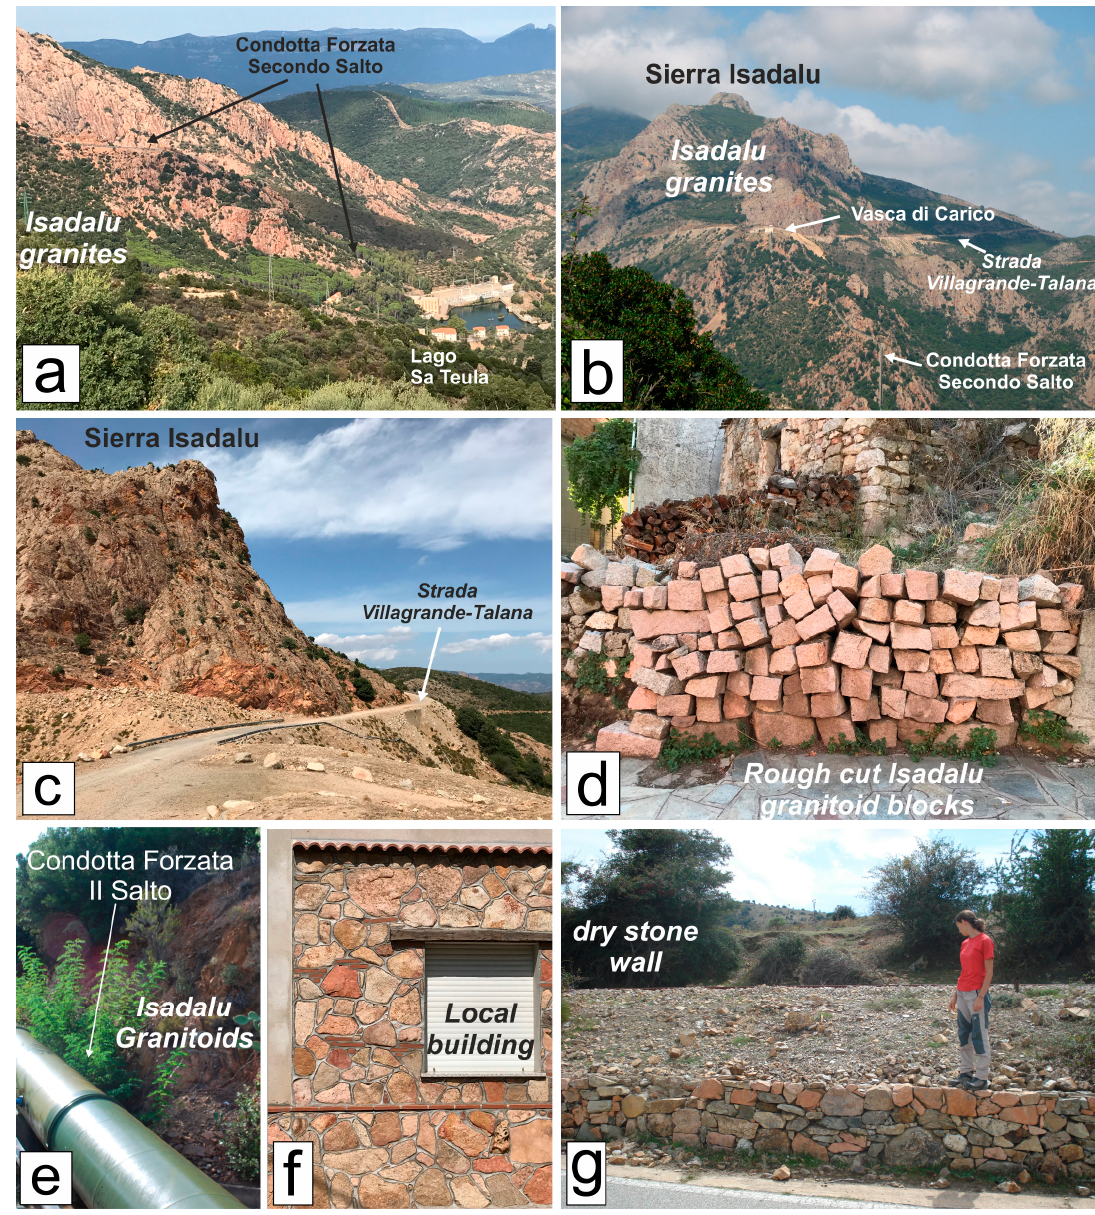
Figure 2. The Isadalu Hbl-bearing granites in anthropic environment: ( a ) penstocks, Sa Teula artificial basin and watermills of the Secondo Salto hydroelectric plants; ( b ) eastern view of Sierra Isadalu with localization of the main infrastructures; ( c ) the collapsing regional Villagrande Strisaili-Talana road, built over Isadalu granites; ( d ) Isadalu Hbl-bearing granitoid as geomaterial: rough cut blocks used for local buildings; ( e ) the penstocks and their relationship with Isadalu granitoids; ( f , g ) Isadalu granitoid blocks used for houses and dry stone walls.